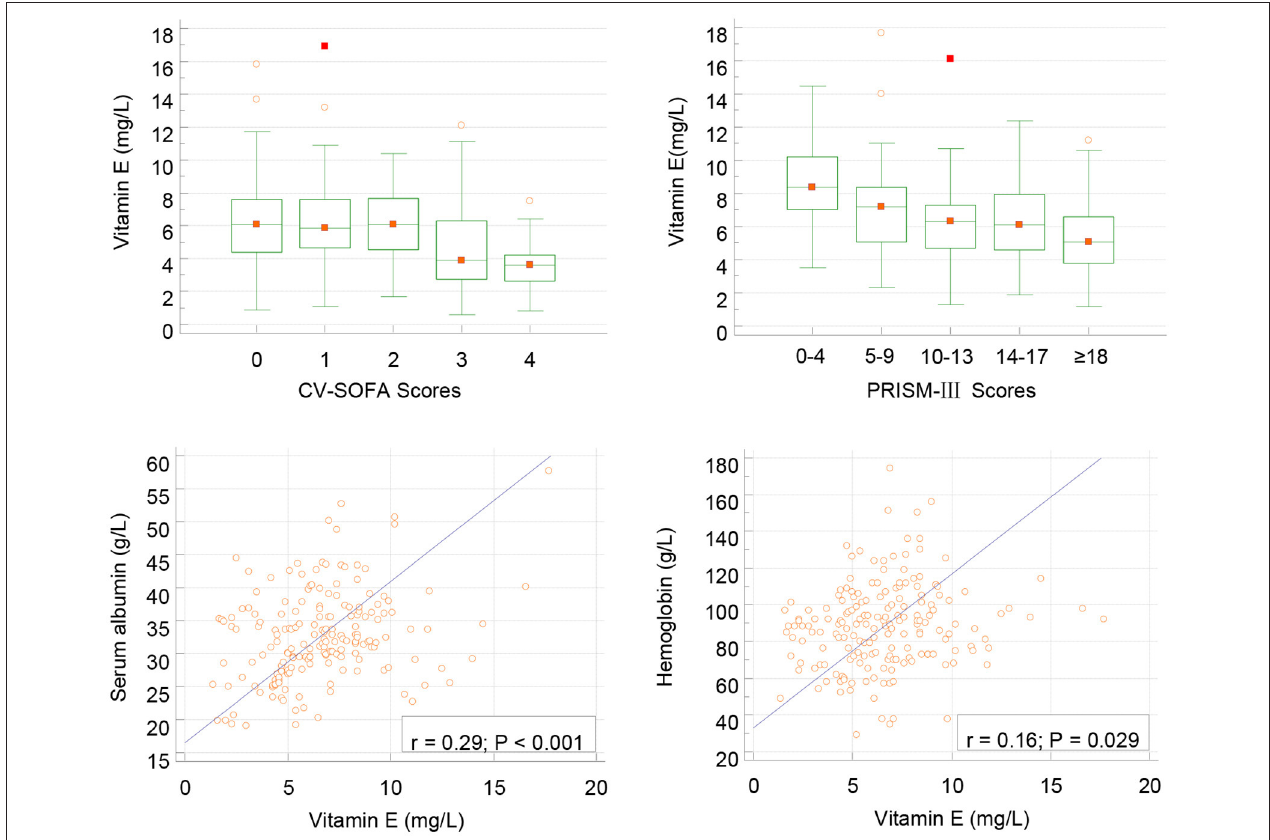
FIGURE 2 | Correlation between serum vitamin E and CV-SOFA ( r = − 0.249, p < 0.001), PRISM-III ( r = − 0.238, P = 0.001) scores, albumin and hemoglobin levels (Pearson’s) in critical children with